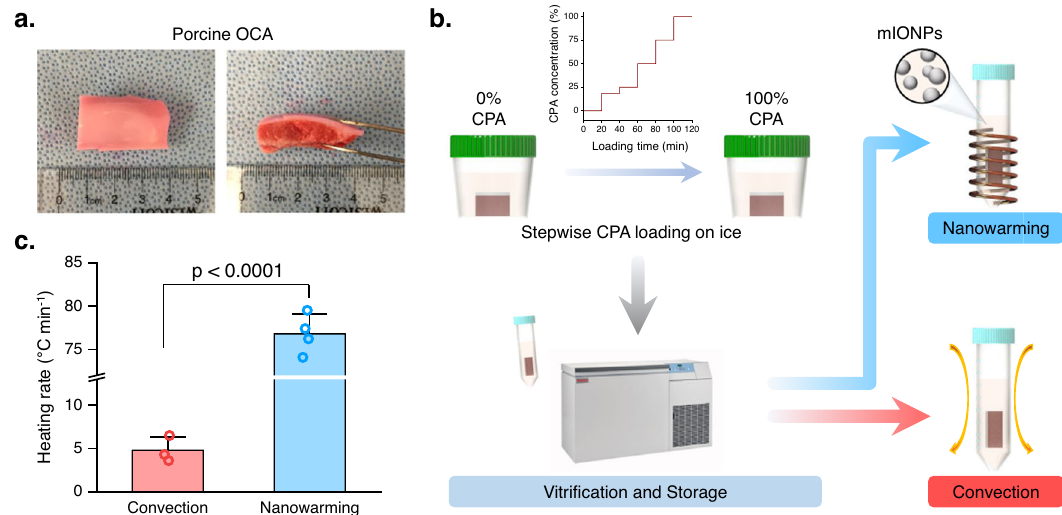
Fig. 1 Large OCA nanowarming and ice-free cryopreservation vs. conventional cryopreservation. a Porcine femoral trochlea OCA used in this study. The OCA size is ~30 mm × 20 mm × 14 mm (length × width × thickness). b Schematic fl ow of two cryopreservation methods. For both strategies, the